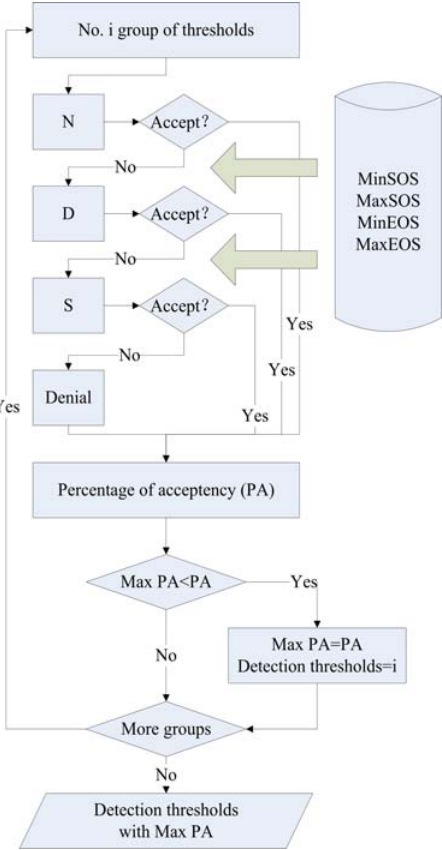
Figure 5. Algorithm for determining phenology detection